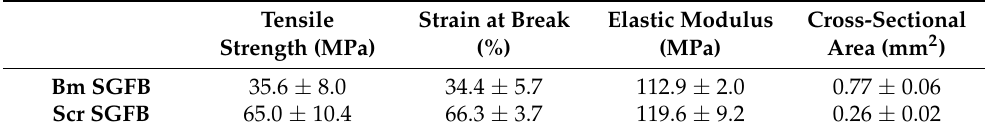
Table 5. Values of mechanical properties and cross-sectional areas of silkworm gut fibre braids produced from silk glands of S. c. ricini (Scr SGFB) and from B. mori (Bm SGFB), prehydrated in 1 × PBS. Expressed as average values ± standard